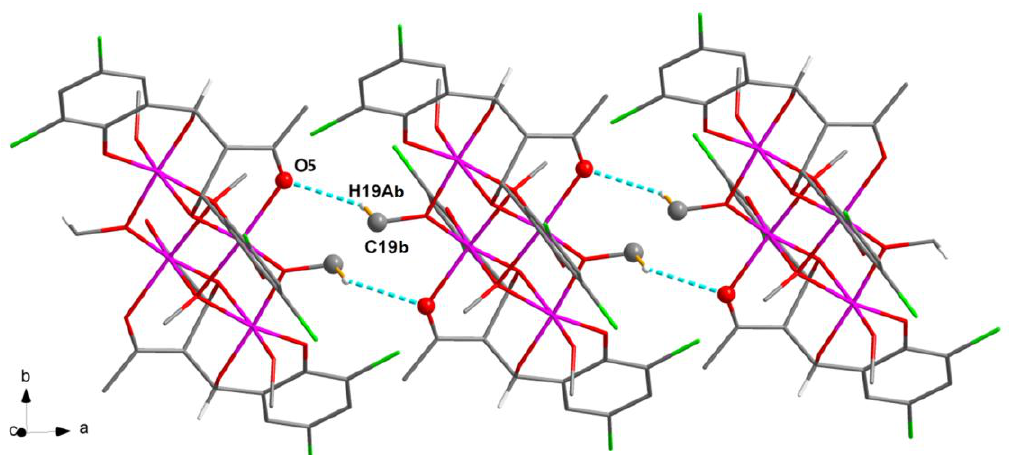
Figure 6. Part of 1D supramolecular structure containing C19b–H19Ab···O5 hydrogen bond interactions along a axis of the Mn III complex 1 (symmetry code: b = 2 − x, 1 − y, 1 − z).